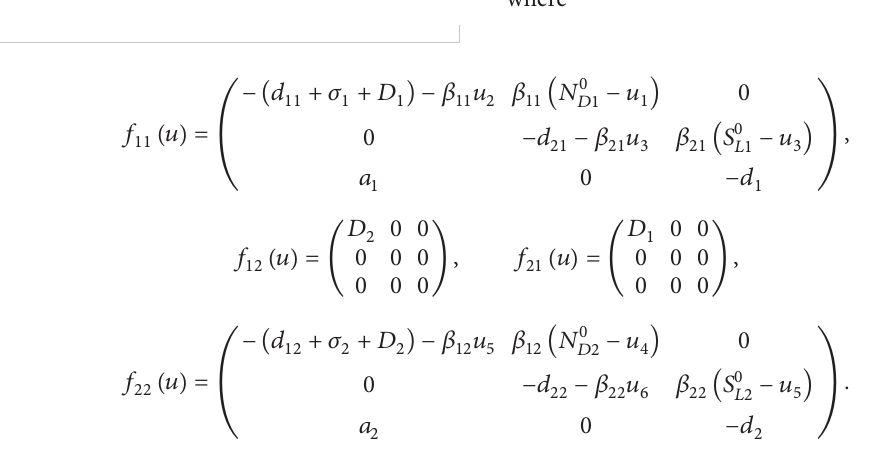
Figure 6: Time series of echinococcosis disease 𝐼 𝐿𝑖 , 𝑖 = 1, 2 , when the two patches are isolated for the parameters given in Example 9.